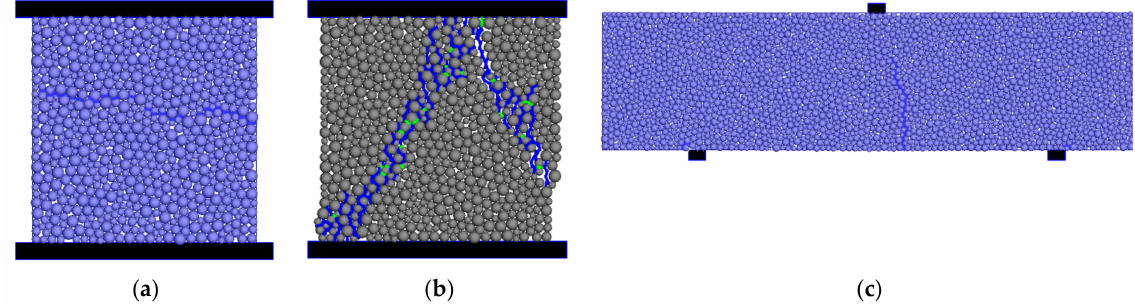
Figure 5. Final crack patterns: ( a ) Tensile test 0.04 m × 0.04 m × 0.04 m; ( b ) Compression test 0.04 m × 0.04 m × 0.04 m); ( c ) Bending test 0.14 m × 0.04 m × 0.04